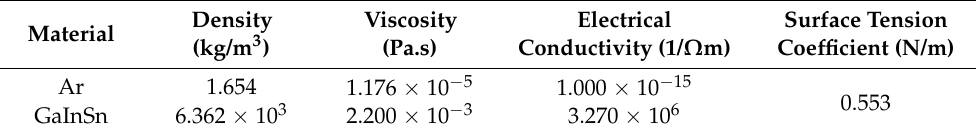
Table 2. Physical properties of materials for validation test.